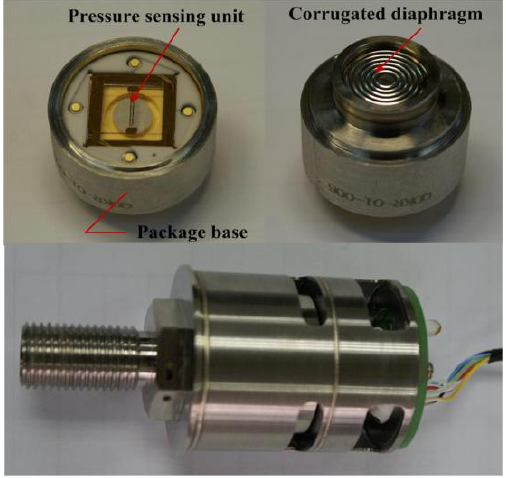
Figure 5. The packaged pressure sensor.